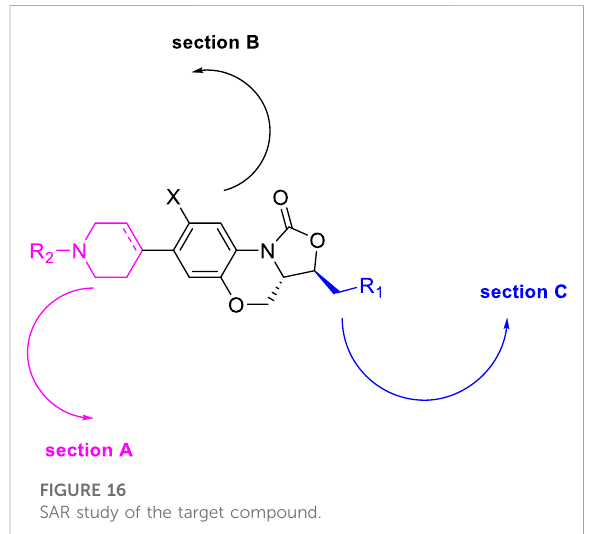
FIGURE 16 SAR study of the target